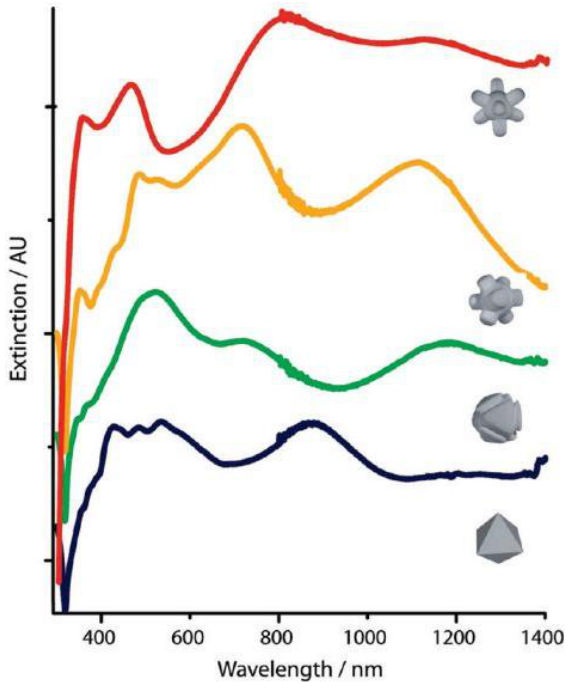
Figure 10. UV-vis-NIR spectra of different stages of the etching progress when starting from octahedral nanoparticles. Interestingly, as the etching progresses the octopod structures have LSPs with greater intensity in the red and near-infrared regions (reprinted with permission from [79]. Copyright (2010) American Chemical